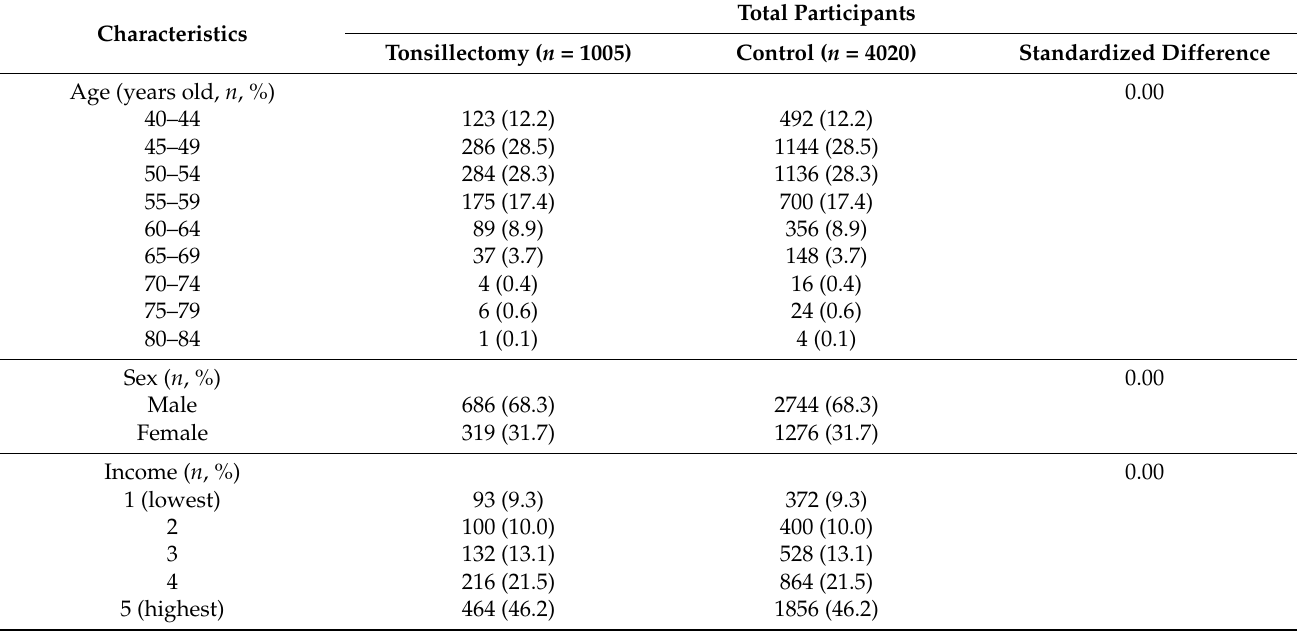
Table 1. General characteristics of the